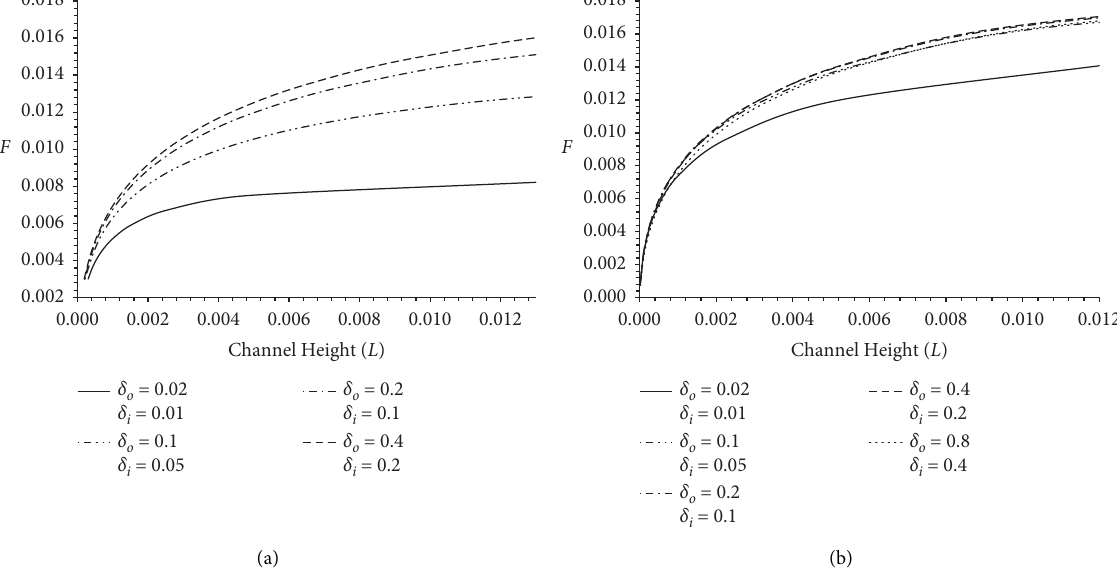
� 10, E � 0.5, χ � 0.5; (a) case I and (b) case o and δ i , K r 2